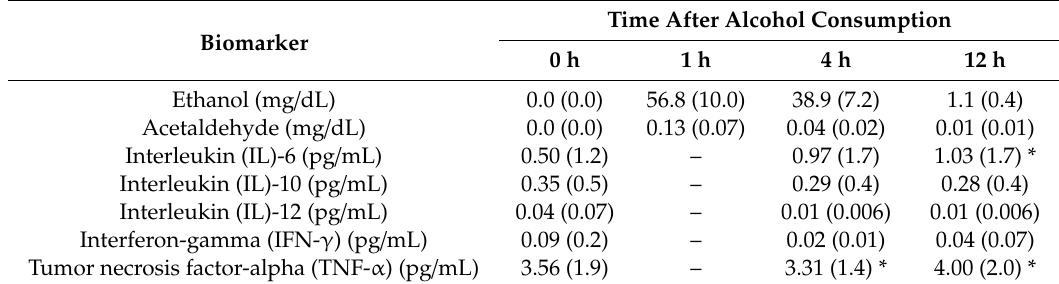
Table 1. Biomarkers of alcohol metabolism, the inflammatory response to alcohol consumption and their relation to hangover severity.